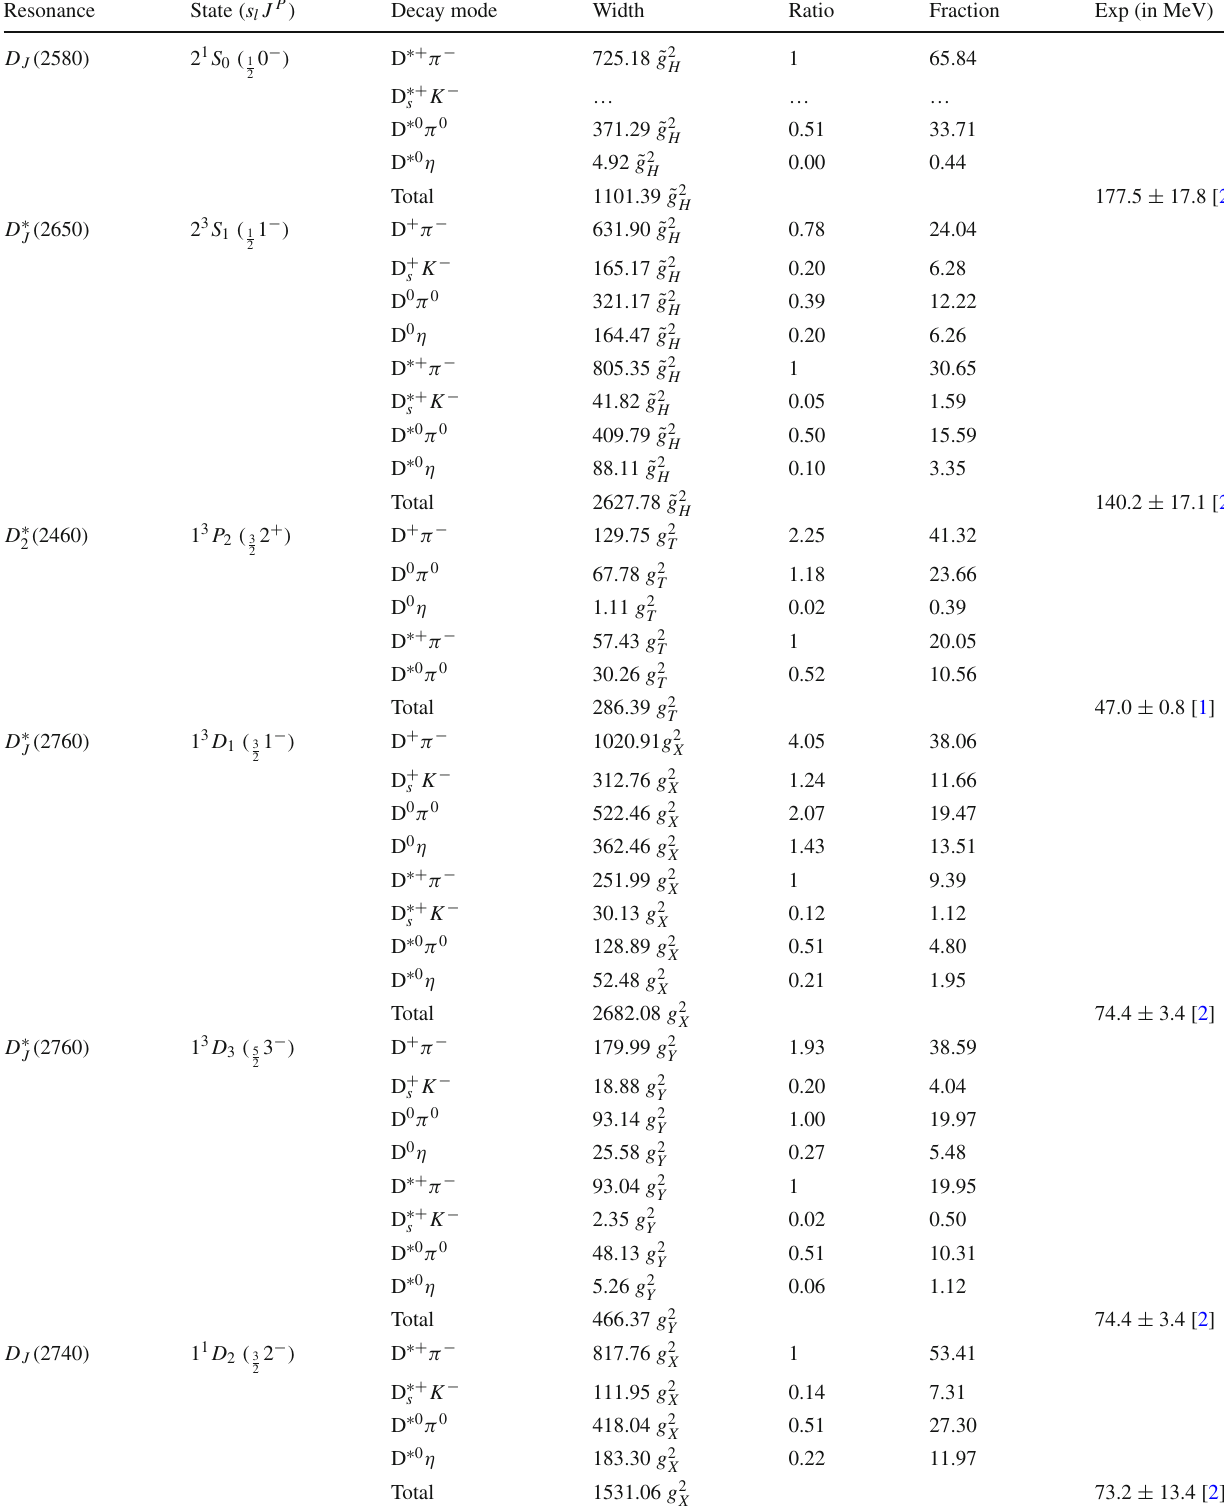
Table8 Thestrongdecaywidths(inMeV)forcharmedresonancewithpossiblespin-parityassignments.Theratioiscalculatedfrom (cid:21) (cid:21)( Fraction (in%) represents the percentage of the partial decay width with respect to total decay width